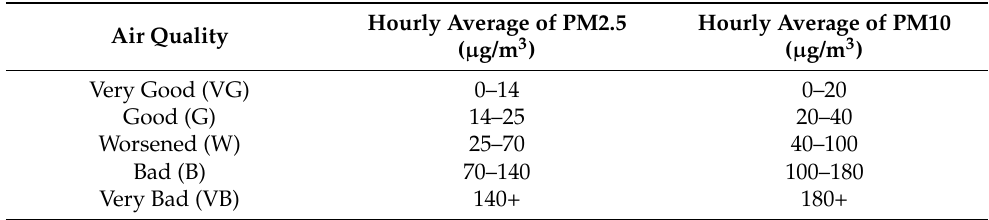
Table 4. Limit values for hourly averages of PM2.5 and PM10 mass concentrations. Adapted from